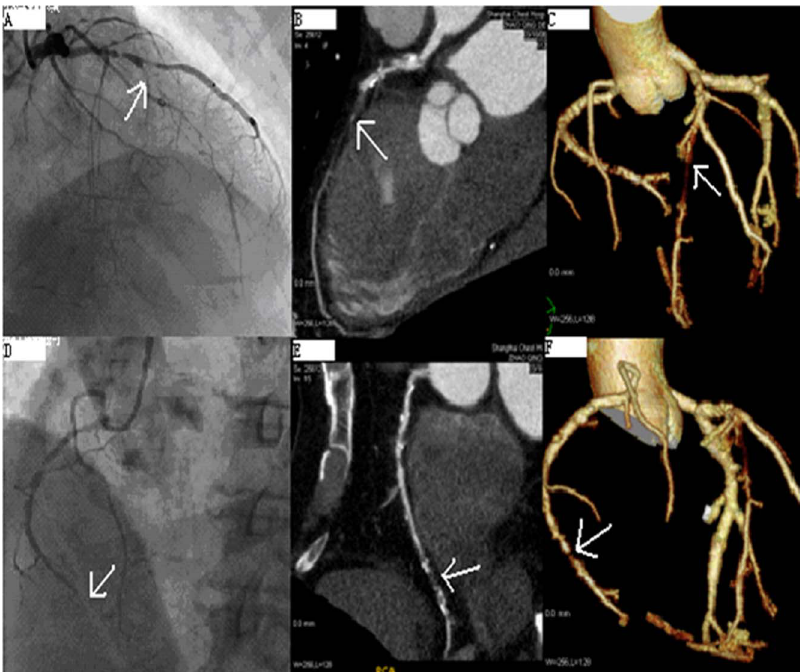
Figure 1. Representative Reconstructed Images of CTO Lesions at the Left Anterior Descending Coronary Artery (LAD) and Right Coronary Artery (RCA). 1A, 1D: Coronary angiography (CAG) image; 1B, 1E: Multiplanar reconstruction images; 1C, 1F: Three-dimensional volume rendering (Tree) image. doi:10.1371/journal.pone.0098242.g001 PLOS ONE |